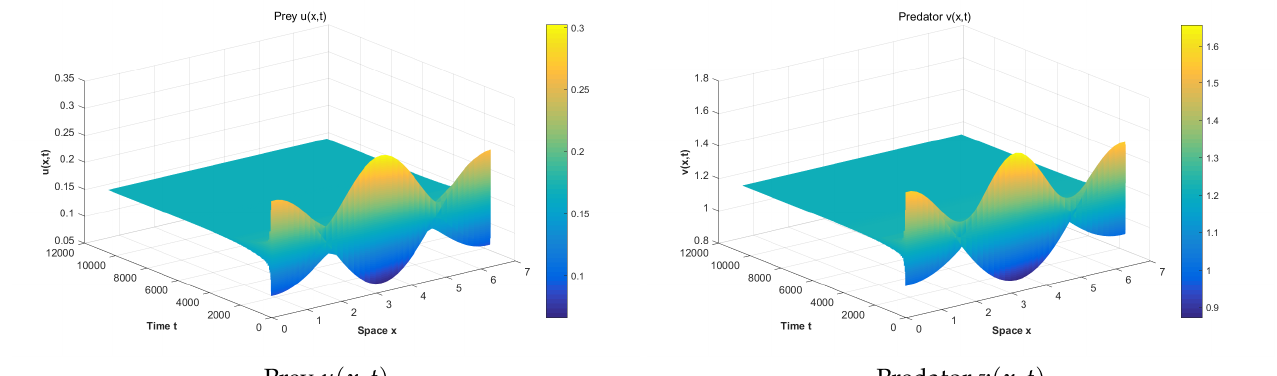
Figure 4. The numerical simulations of system (2) with d = 0.7 and τ =